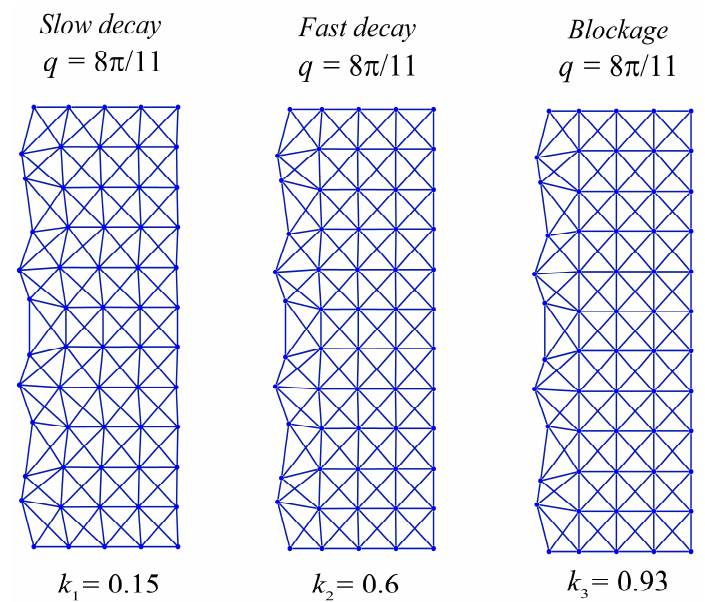
Figure 8. Deformation configurations (scaled) of different stiffness parameters under a Raleigh mode solution for q = 8 π in a half-cyclic domain of the x-braced lattice ( m = 0 → 11, n = 0 → 4 ).